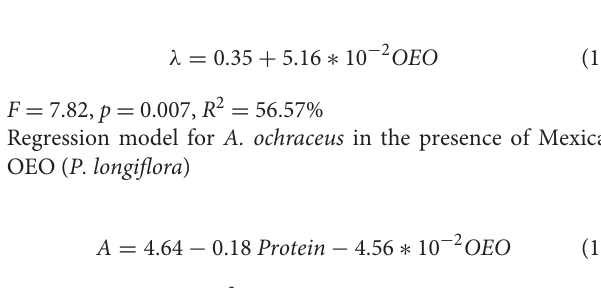
TABLE 2 | Box-Behnken design for evaluation of pH, protein content, and Mexican oregano essential oil, on the growth of food-related fungi. Treatment % protein pH Mexican oregano